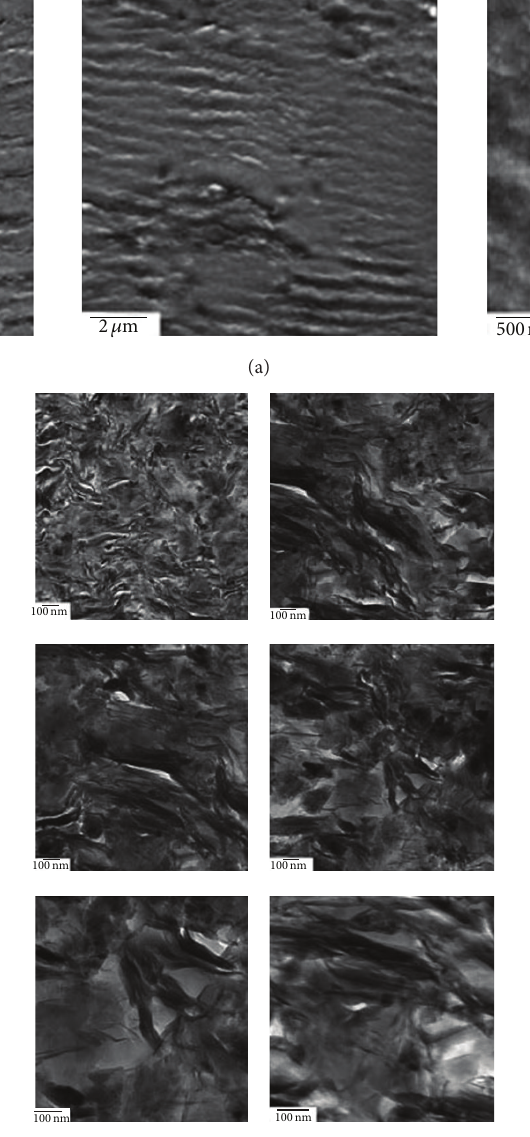
Figure 2: TEM micrographs of (a) M. chitosan-MMT/ibuprofen (1:1) on cold and (b) M. chitosan-MMT/ibuprofen (1:1) on hot.